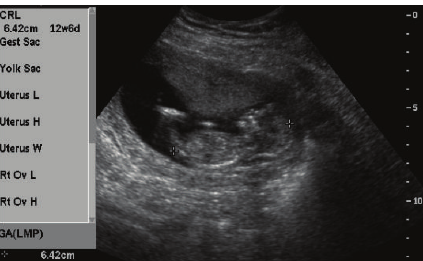
Figure 4: Patient number 2, pelvic sonogram on 4/2/15: showing IUP at 12 6/7wks, while both Essure inserts are still in place.